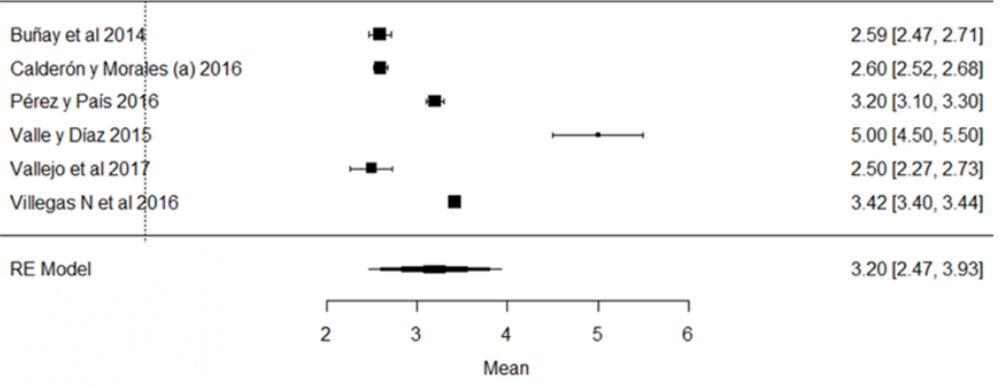
Figure 13. Forest plot of reductase presence [19,35,38,39,52,54].